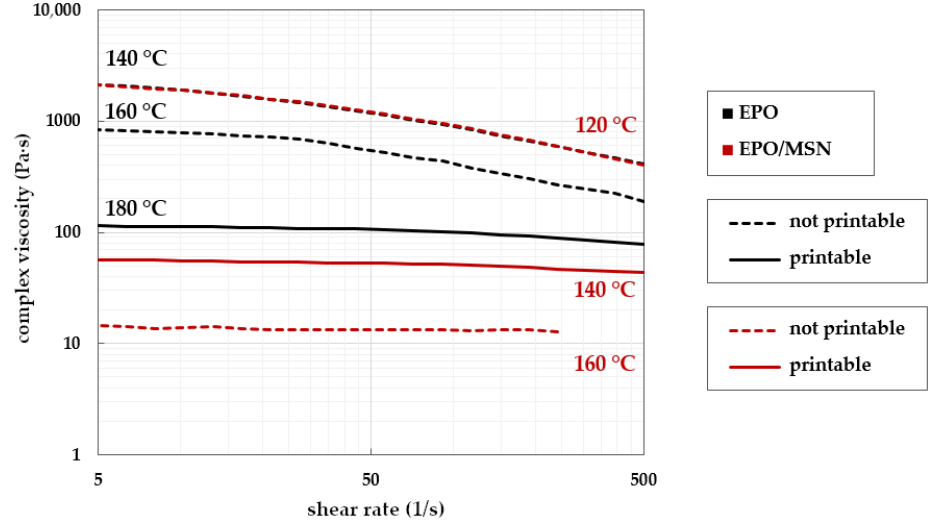
Figure 7. Complex viscosities of placebo formulation EPO (black lines) and EPO/MSN (red lines) in relation to shear rate monitored at different temperatures; temperatures for successful print runs are symbolized by continuous lines, unsuitable print runs in dotted lines.